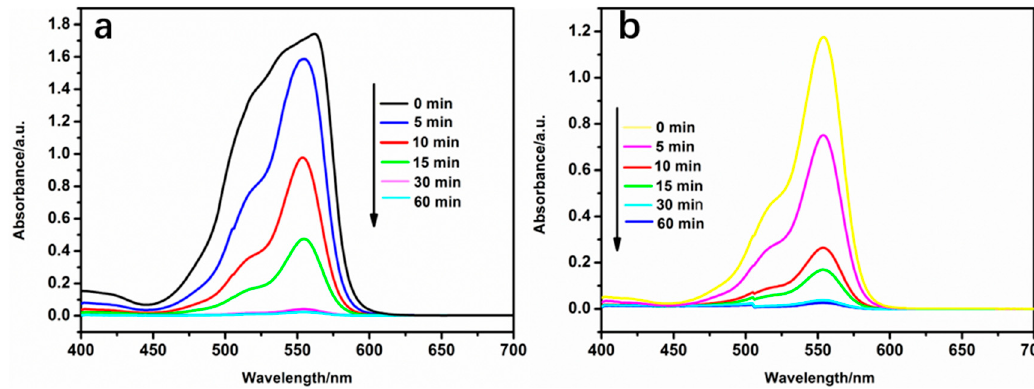
Figure 7. Absorption spectra of ( a ) RB and ( b ) ST at different adsorption times by PMMA@Fe 3 O 4 @DR.